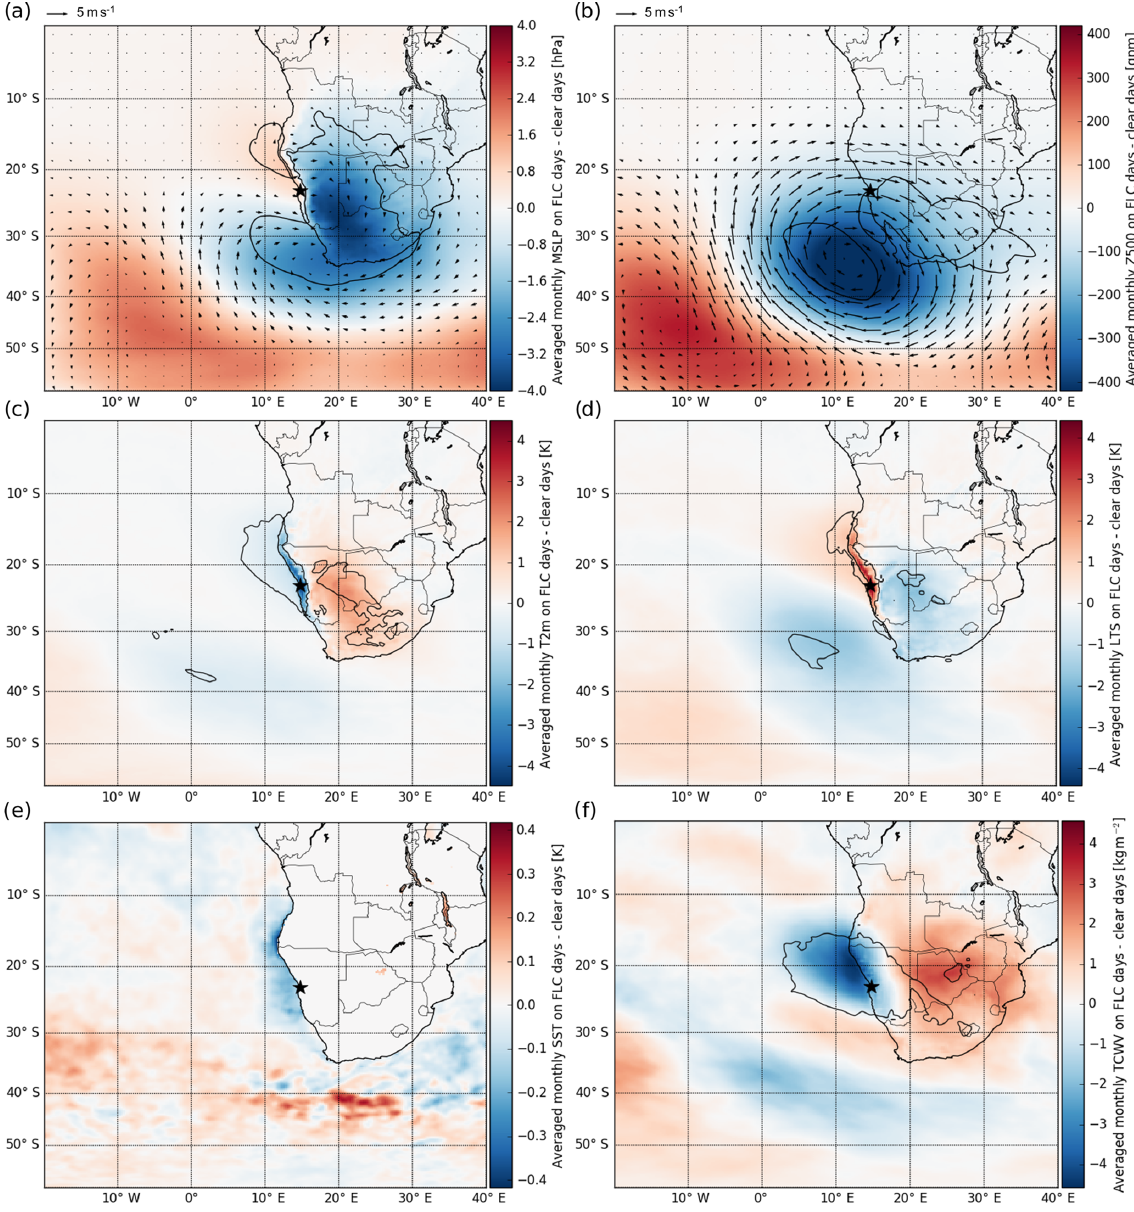
Figure 3. Averaged monthly mean differences (FLC days − clear days) in (a) MSLP and 10m winds, (b) Z500 and 500hPa winds (in geopotential meters, gpm), (c) T2m, (d) LTS, (e) SST, and (f) TCWV at 06:00UTC. In each pixel, an independent two-sided t test is computed to identify significant differences between FLC and clear days for each month. Contours mark regions where the distributions differ significantly at the 0.01 level (median of the monthly p values < 0 . 01). U and v vectors of wind are interpolated as in Fig.